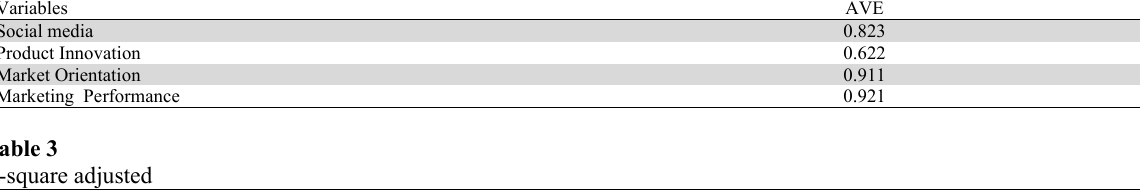
Average variance extracted (AVE)